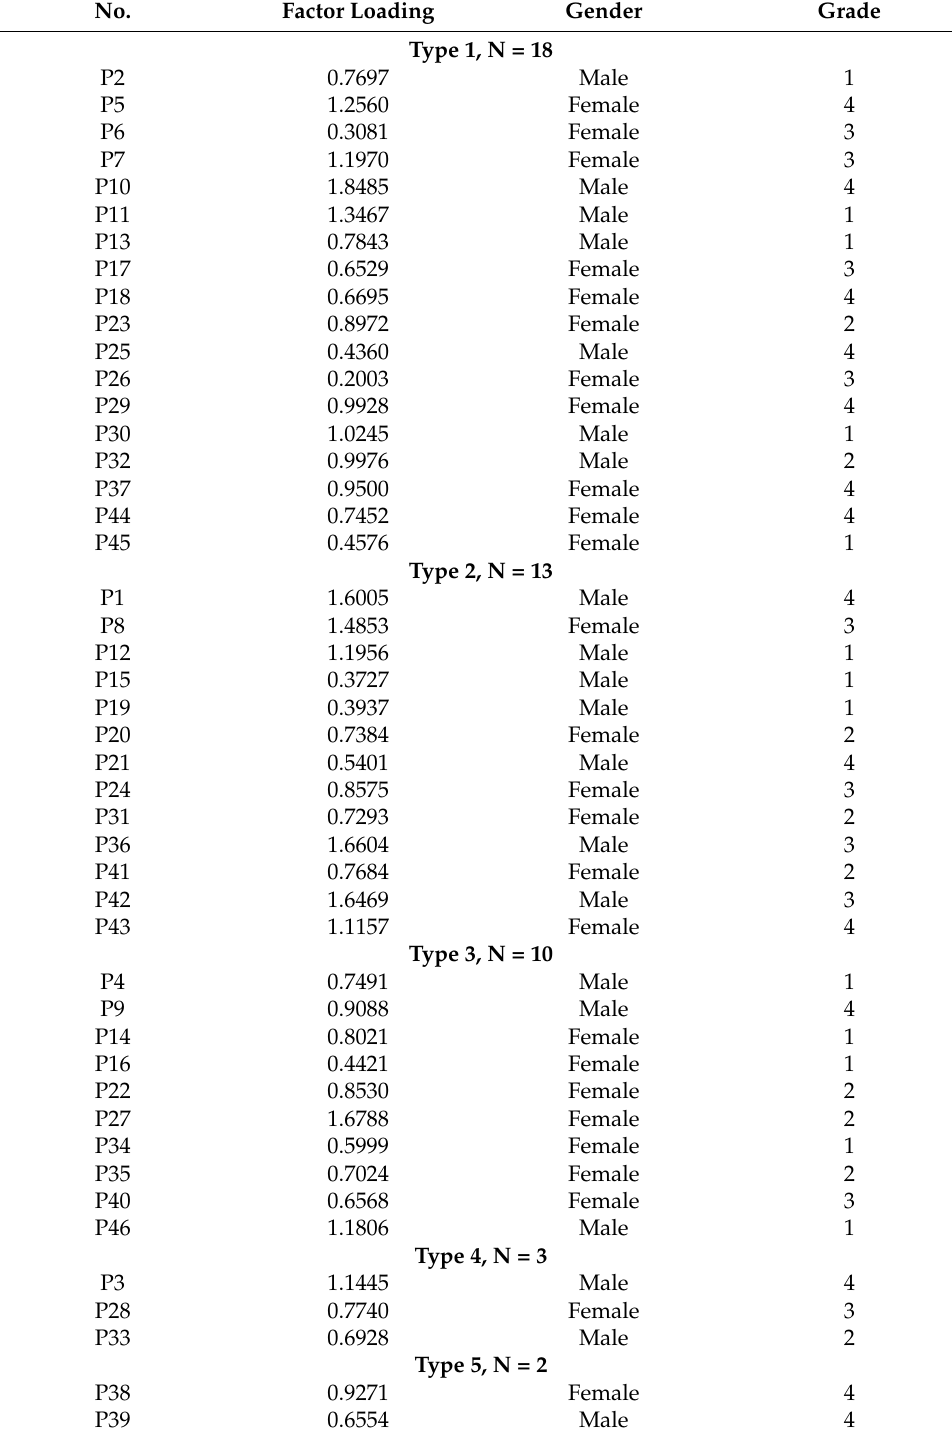
Table 6. Subjects and Factor Weights by